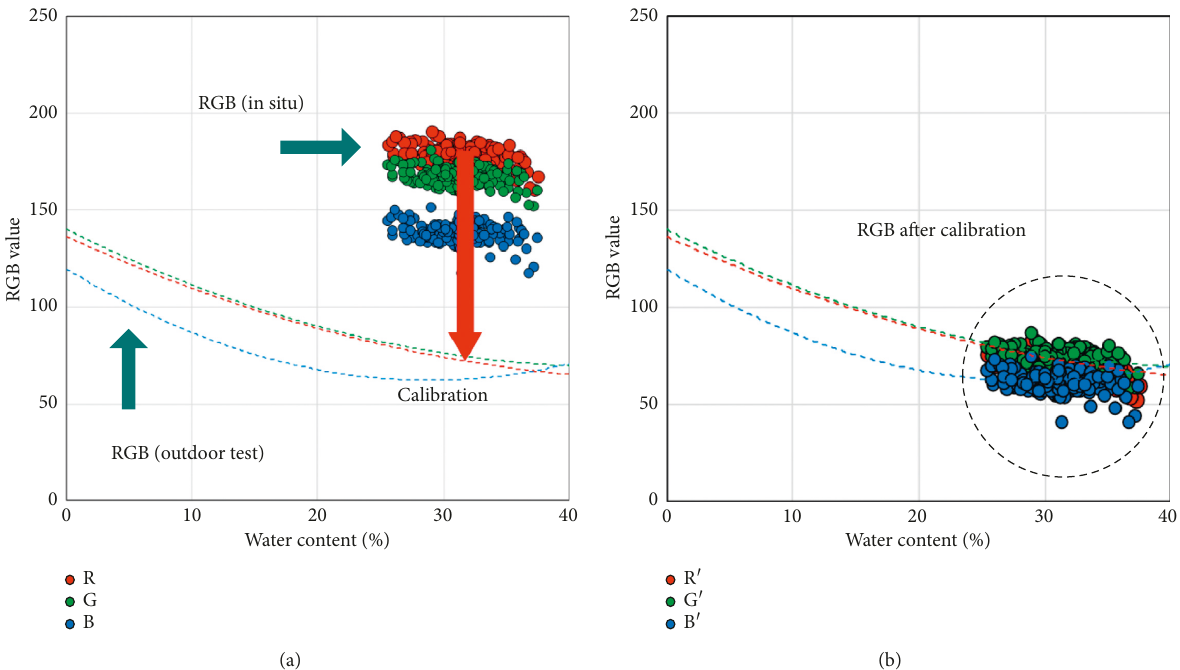
Figure 3: Calibration of RGB for the water content estimation formula: (a) before calibration; (b) after calibration.